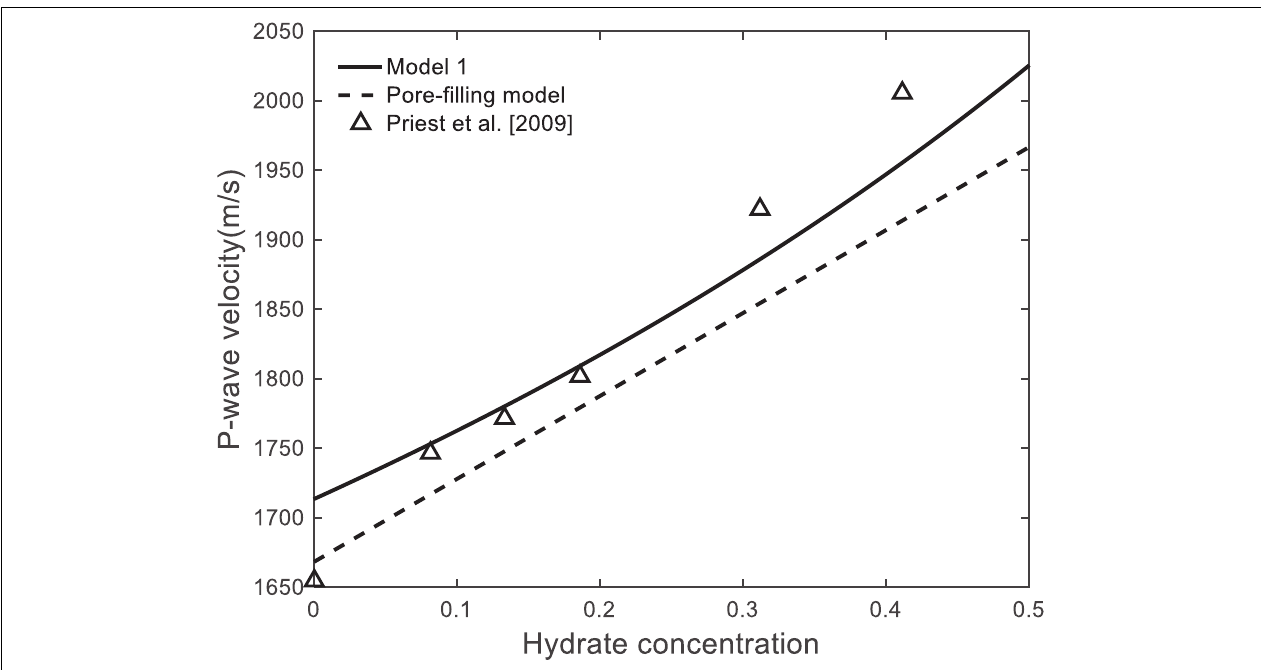
FIGURE 11 | Model 1. P-wave velocity as a function of hydrate concentration. The frequency is around 200 Hz. The pore-filling model curve and the experimental data (triangles) are taken from Priest et al. (2009).